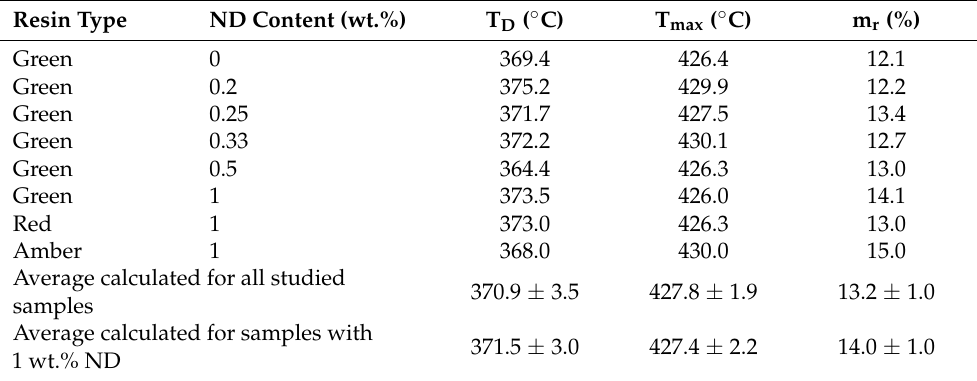
Table 2. TGA results of MDPs–polymer composites: TD—degradation temperature at which mass loss reaches 5%, T max —temperature corresponding to a maximum rate of decomposition, mr—weight percentage of the residue at 800 ◦ C.